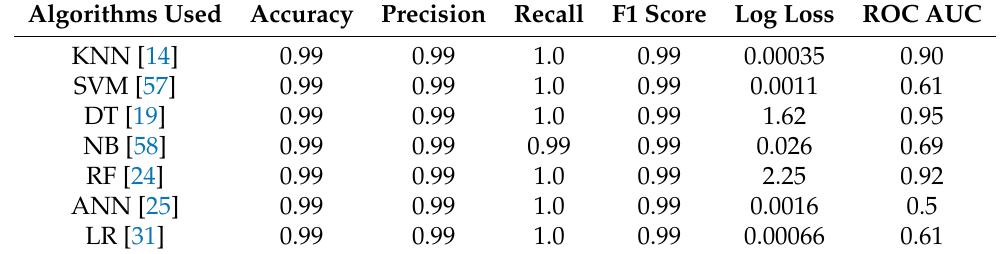
Table 34. DoS TCP results.